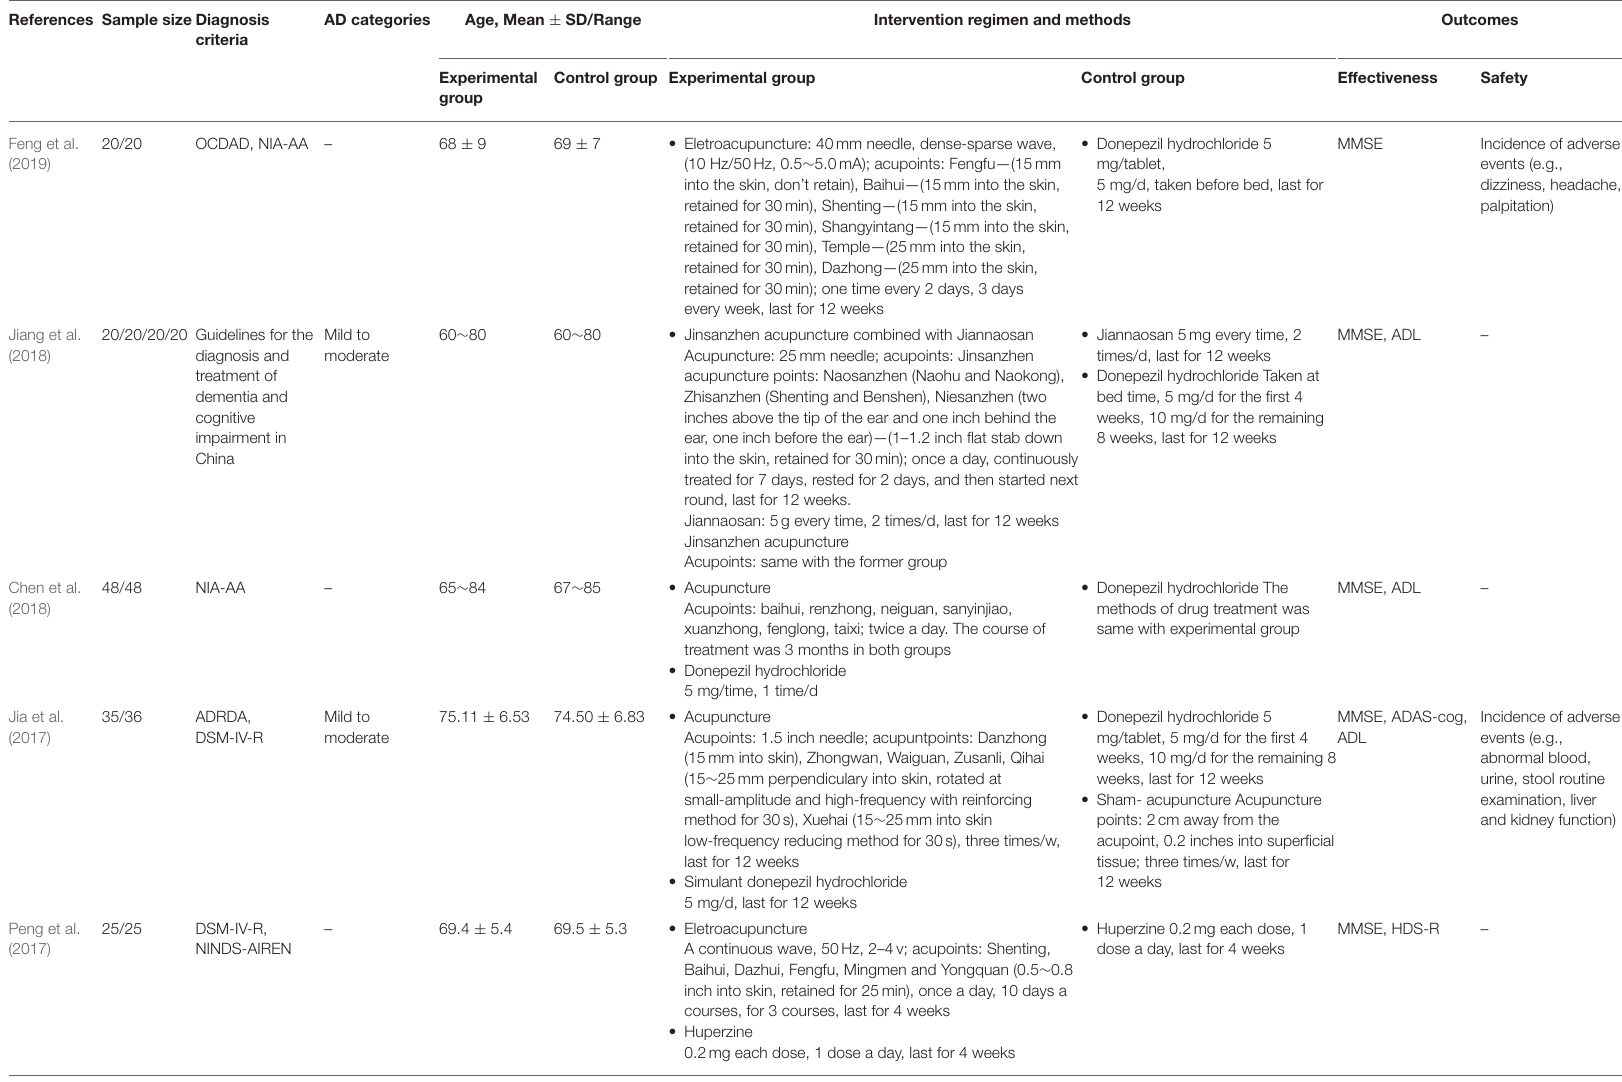
TABLE 1 | The characteristic of RCTs